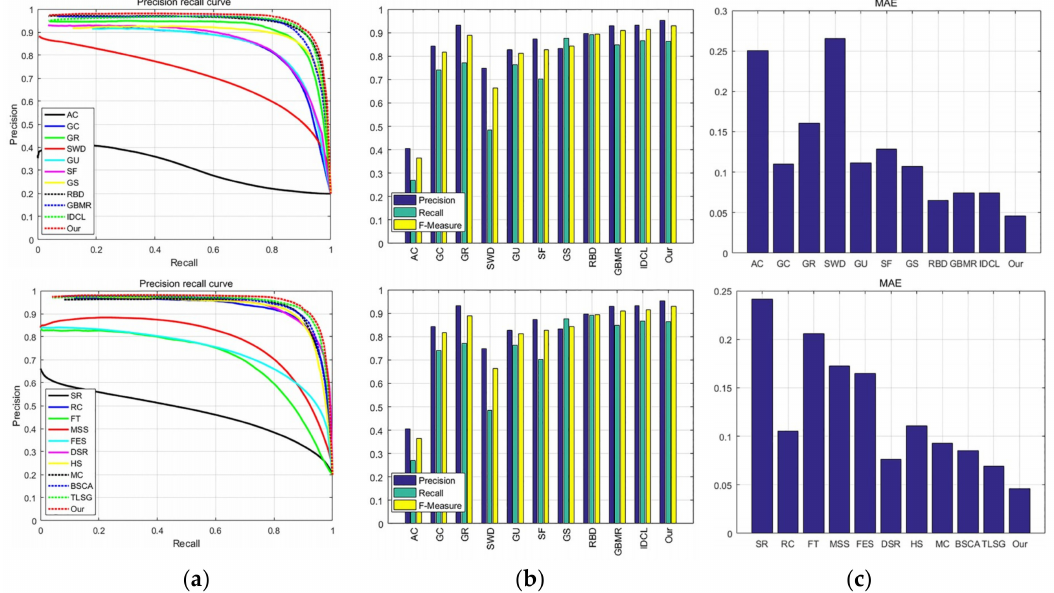
Figure 13. The comparison results on the ASD dataset. ( a ) Precision-recall curves. ( b ) Precision, recall, and F-measure at adaptive threshold. ( c ) Mean absolute error